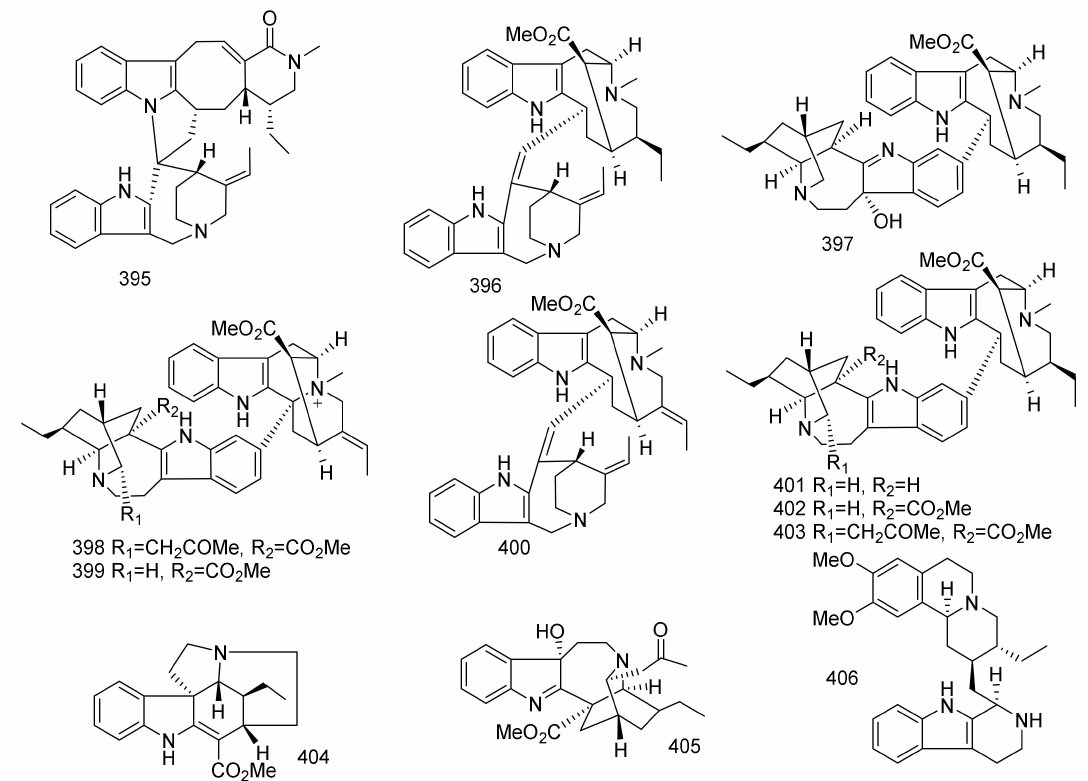
Figure 31. Compounds 395 – 406 .